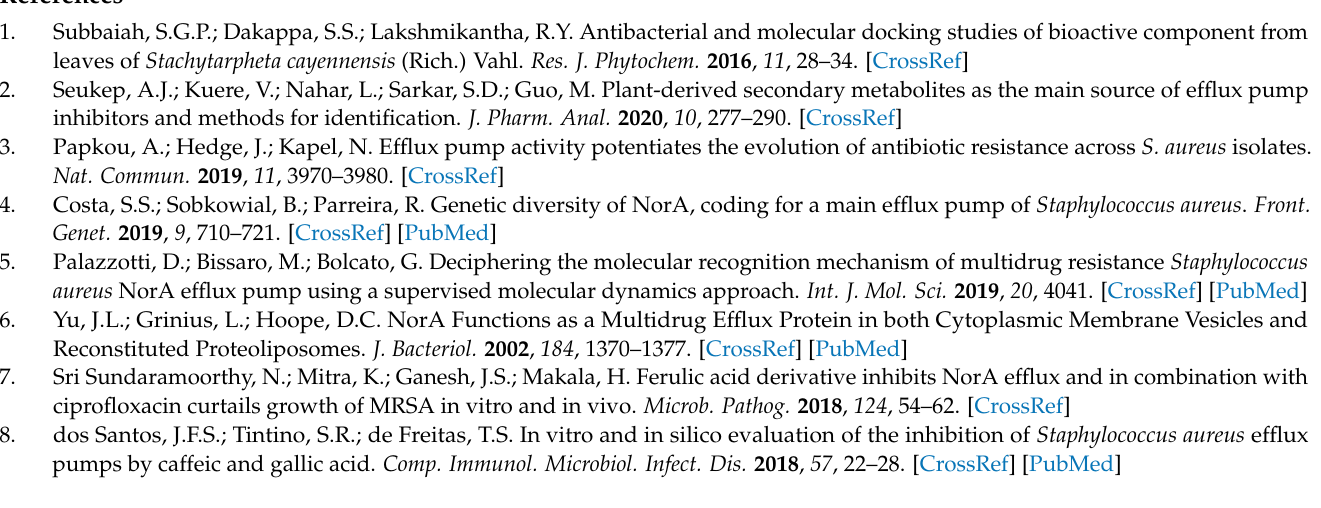
Timeline plot of all the contacts (top panel) and specific contacts p-coumaric acid makes on amino acids of NorA (bottom panel).